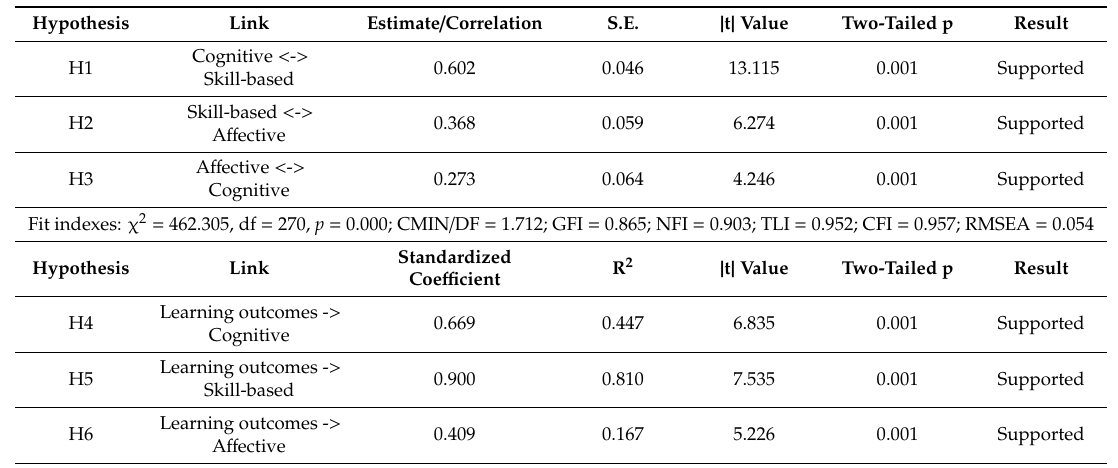
Table 3. Results of the measurement and structural